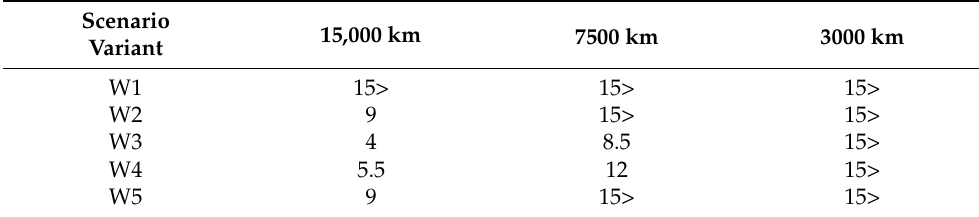
Table 6. Simulation results: after what time a gasoline car will produce higher kg-CO 2 emissions than an electric car, depending on the average annual mileage and electricity